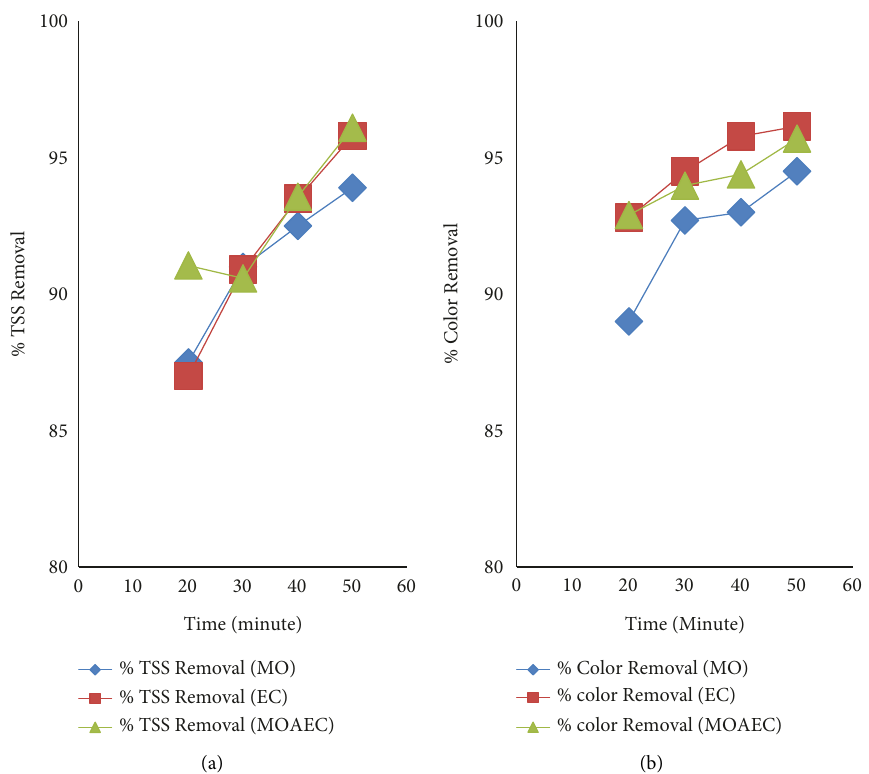
Figure 5: Effects of time on removal efficiency of TSS (a) and color (b) using Moringa Oleifera (MO), the electrocoagulation process (EC), and the Moringa Oleifera -assisted EC process